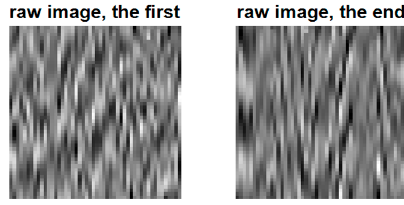
Figure 14. Primitive raw images for EEG data signal for the selected first and last trials (50 × 50) in C4D2a_4C.